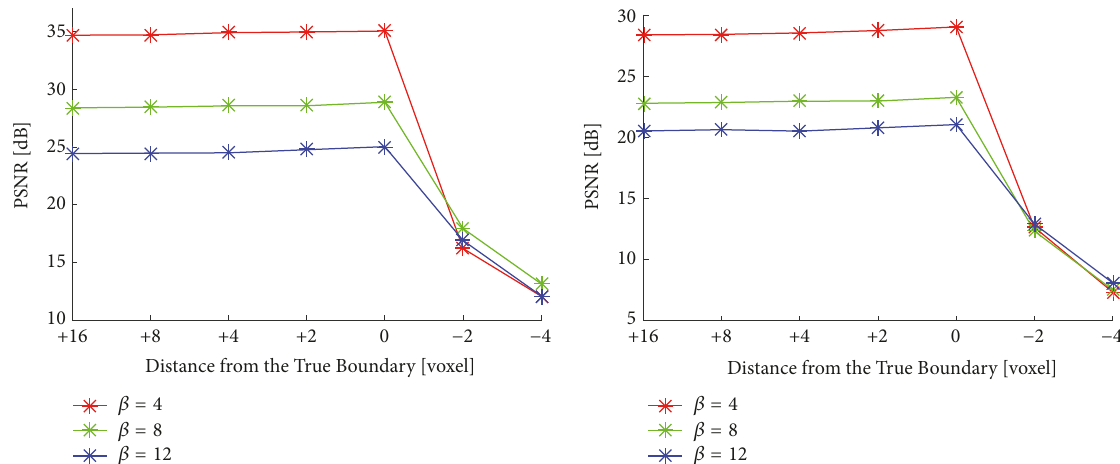
Figure 10: Differences in PSNR performance of the proposed method when the boundary became redundant (positive values) or insufficient (negative values) compared with the true boundary (the value is zero). The input image of the left figure was T1-weighted image of normal brain phantom, and that of the right one was T2-weighted image of lesional brain